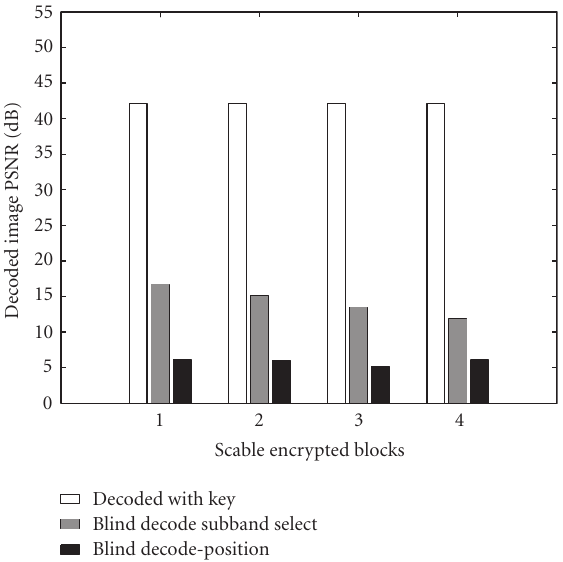
Figure 5: Selective encryption performances. Decoded image qual- ity with di ff erent number of encryption blocks for “building” im- age.